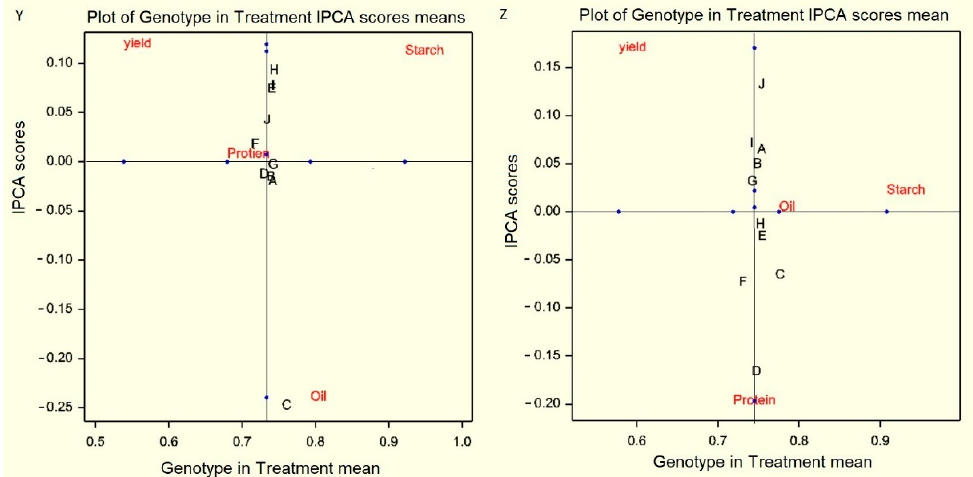
Figure 3. AMMI Biplot of yields in hybrids ( Y ): NPK fertilizer ( Z ): N fertilizer; A (FAO300), B (FAO330), C (FAO340), D (FAO350), E (FAO380), F (FAO360), G (FAO420), H (FAO490), I (FAO370), J (FAO430); Yield (grain yield), Starch (starch content), Protein (protein content), Oil (oil content).